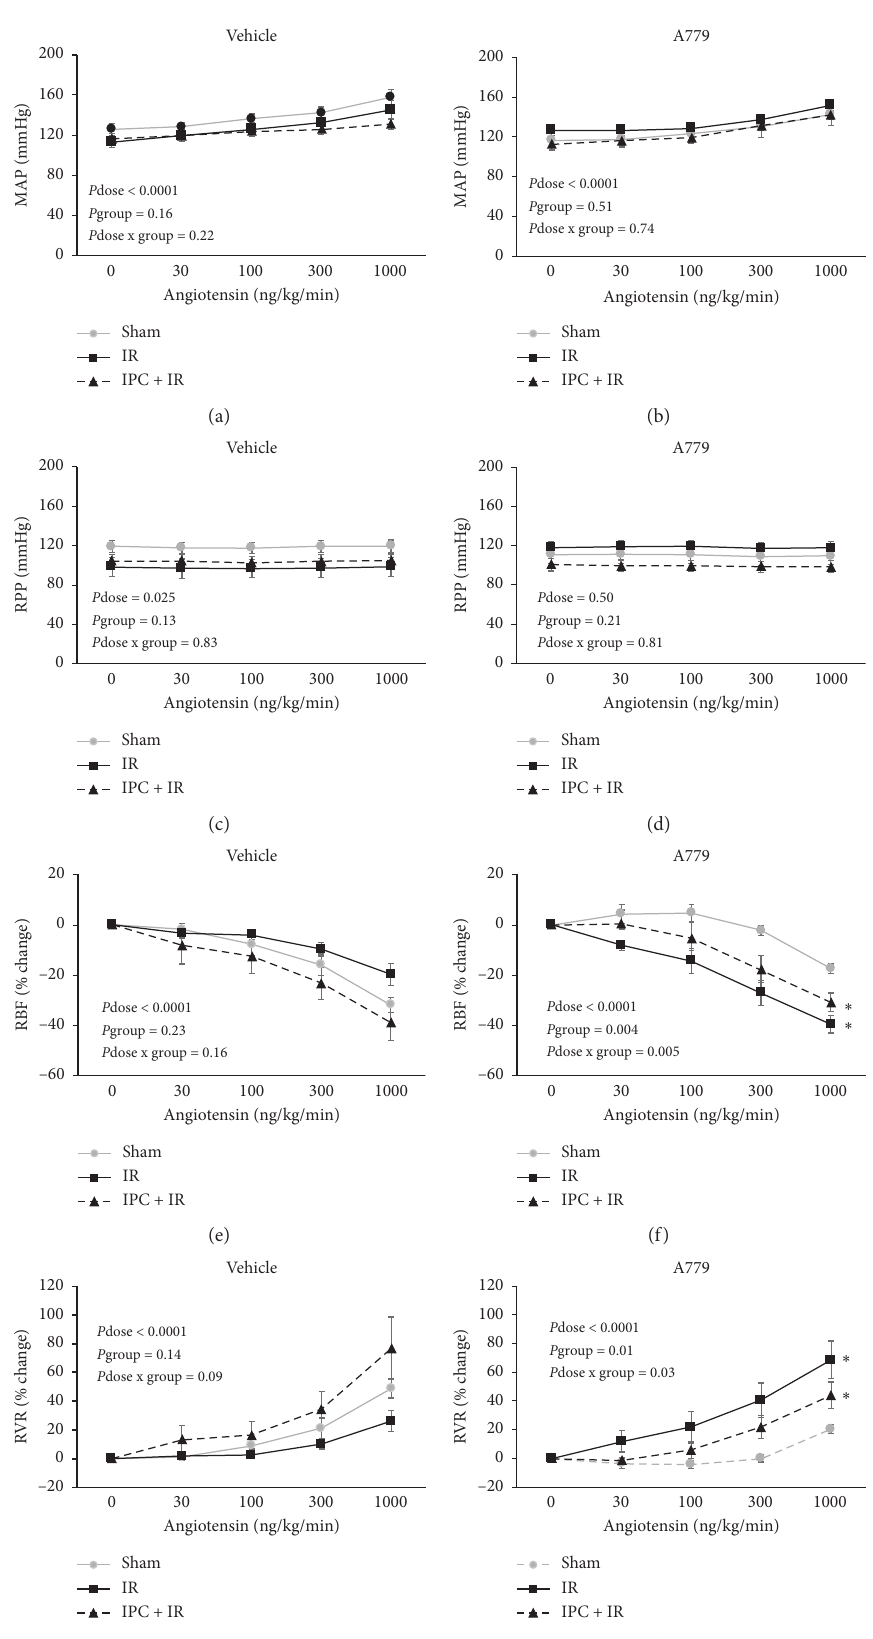
Figure 2: The hemodynamic parameter responses to Ang II infusion. Mean arterial pressure (MAP), renal perfusion pressure (RPP), renal blood flow percentage change (RBF%), and renal vascular resistance percentage change (RVR%) to graded Ang II infusion in sham, IR, and IPC+IR groups treated with A779 or its vehicle. Data are shown as mean ± SEM. The P values were derived from repeated measure ANOVA. ∗ Significant difference from the sham group ( P group <